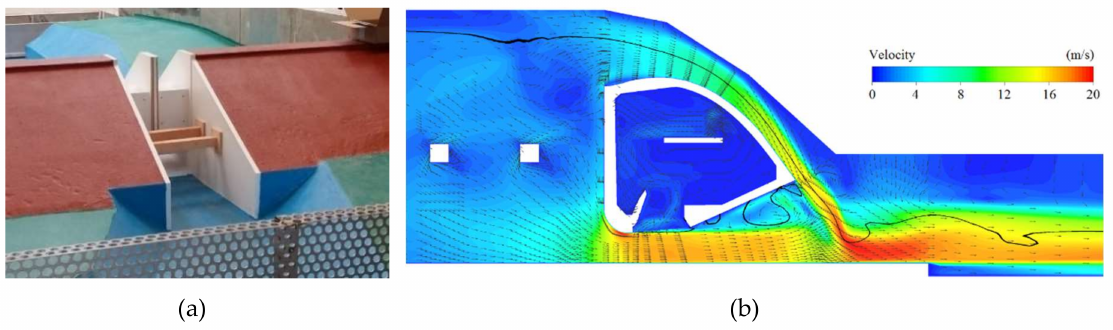
Figure 8. Torpshammar spillway: ( a ) Present physical model ( λ = 30), upstream view; ( b ) CFD results showing the flow pattern at simultaneous operation of all four openings.